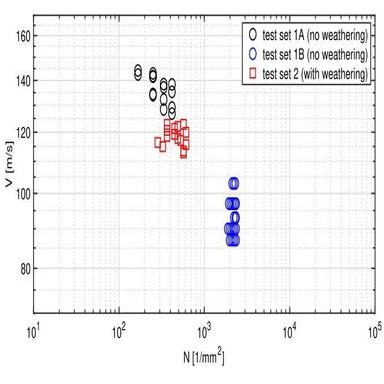
V-N RET test sets.